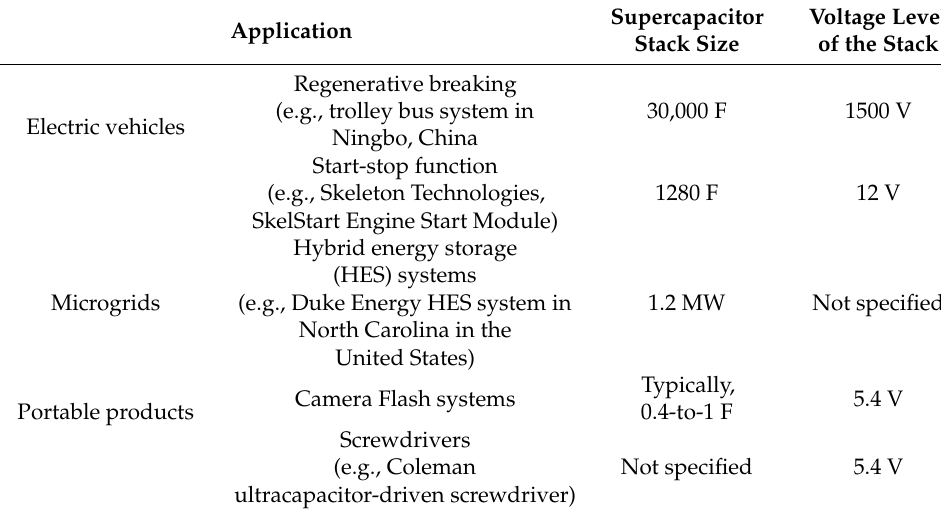
Table 3. Summary of supercapacitor applications [47,56 – 58] .